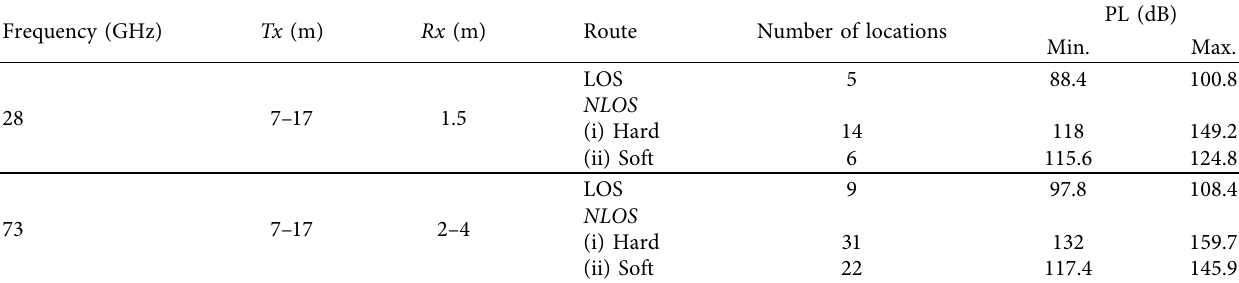
Table 1: Summary of the measurement parameters.